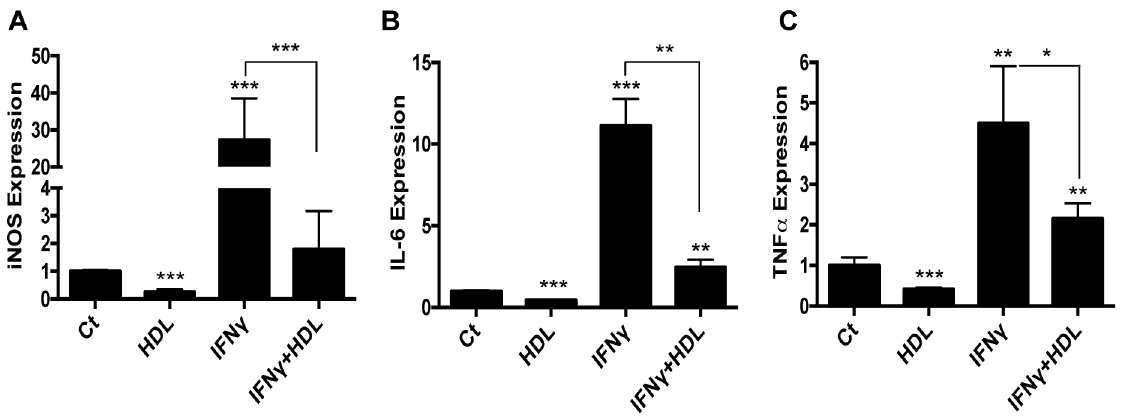
Figure 2. HDL inhibits the basal and induced expression of pro-inflammatory genes in primary macrophages. BMDM were treated for 6h with HDL (50μg/mL), IFNγ (10ng/mL) or both. Gene expression for iNOS (A), IL-6 (B) or TNFα (C) was assessed by real-time qPCR. Results are representative of three independent experiments. Asterisks indicate statistically significant differences, either compared to control, or between 2 conditions when linked by a bar (*p<0.05, **p<0.01, ***p<0.001). doi: